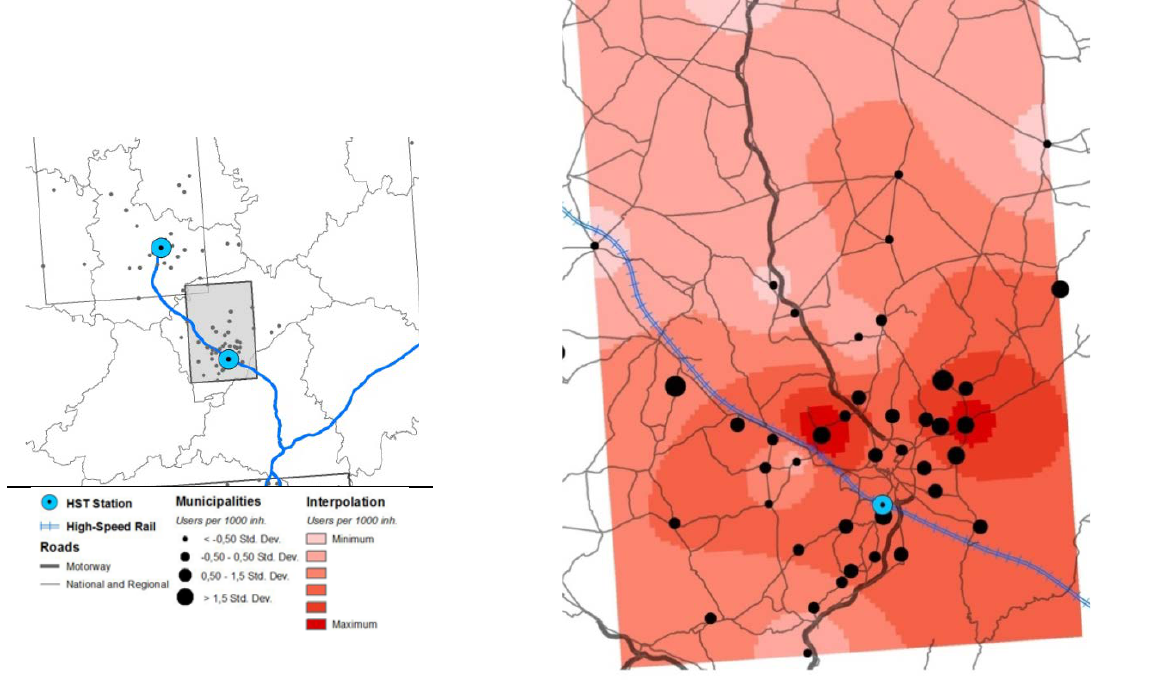
Figure 7. Segovia’s catchment area